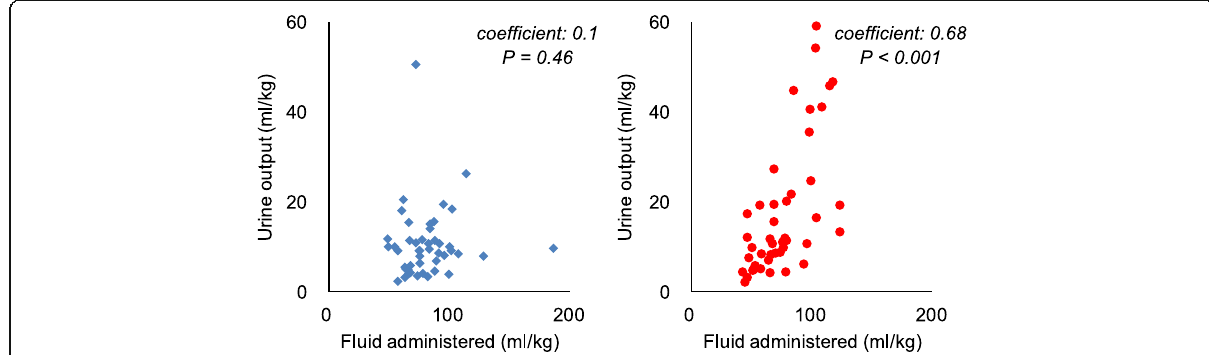
Fig. 4 Relationship between the amount of fluid administered and urine output. a Control group. b GDT group. Coefficient and P values were calculated using Spearman ’ s rank correlation